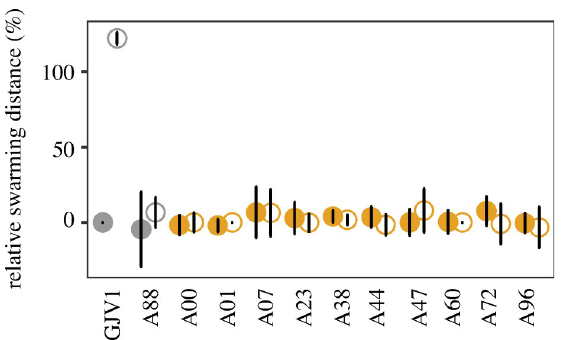
Fig 4. Disruption of traA does not alleviate DK101 inhibition of swarming in natural isolates. The y axis reflects the same relative swarming-distance parameter as in Fig 1. Two strains known (GJV1) or predicted (A88) to be compatible with DK101 for OME at traA are depicted in grey, whereas strains predicted to be incompatible with DK101 for OME are depicted in orange. Parental strains and their corresponding traA mutants are depicted by closed and open circles, respectively. All strains were mixed with DK101 at a 1:9 initial ratio. Error bars show 95% confidence intervals, n = 3 replicates.